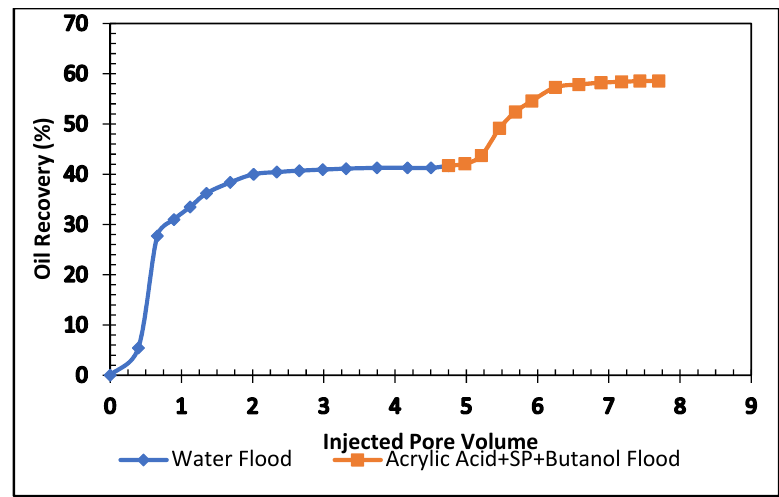
Figure 16. Total oil production from the carbonate core after brine, 0.5% Acrylic acid, butanol and SP mixture, followed by a post-flood with brine.